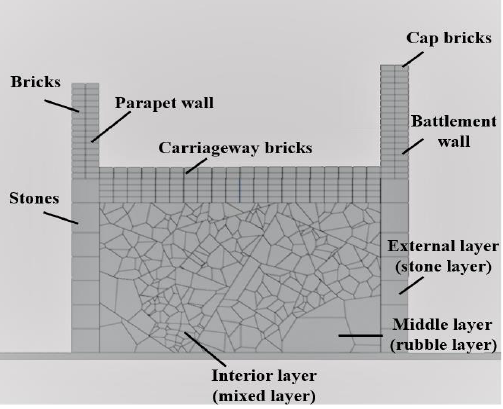
Figure 2. Typical numerical cross section of the Great Wall.